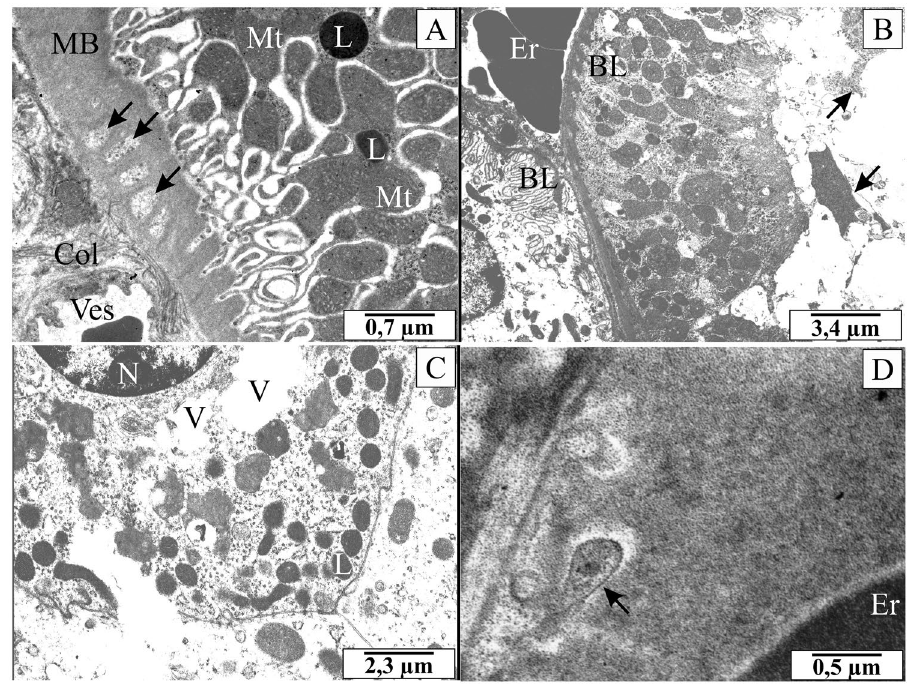
Figure 5. The electronmicrographs showing the rats’ renal medulla invaded B. microti . ( A ) the ultrastructure of the basal membrane with inclusions (arrows). ( B,C ) the ultrastructure of the renal epithelial cells with characteristic vacuolisation and damages. Arrows indicate cellular debris, including erythrocyte fragments. ( D ) merozoite of B. microti in the basal membrane (arrow). BL basal labyrinth, Col collagen, Er erythrocytes, L lysosomes, MB basal membrane, Mt mitochondria, N nucleus, V vacuoles, Ves